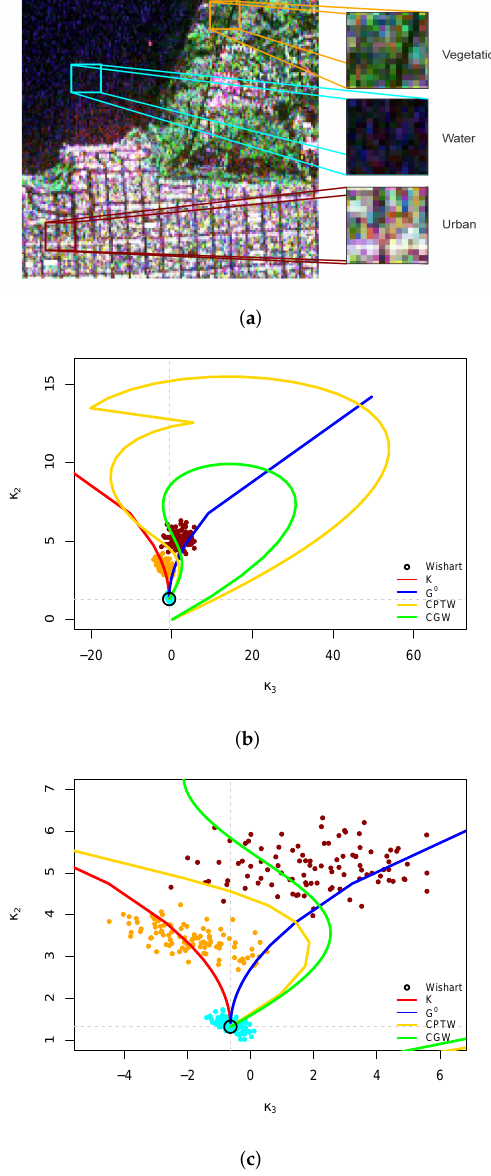
Figure 8. MLC diagram with sample MLCs computed from the samples of San Francisco. ( a ) Subset areas of San Francisco. ( b ) MLC diagram with sample MLCs computed from the samples in ( a ). ( c ) Zoom on the